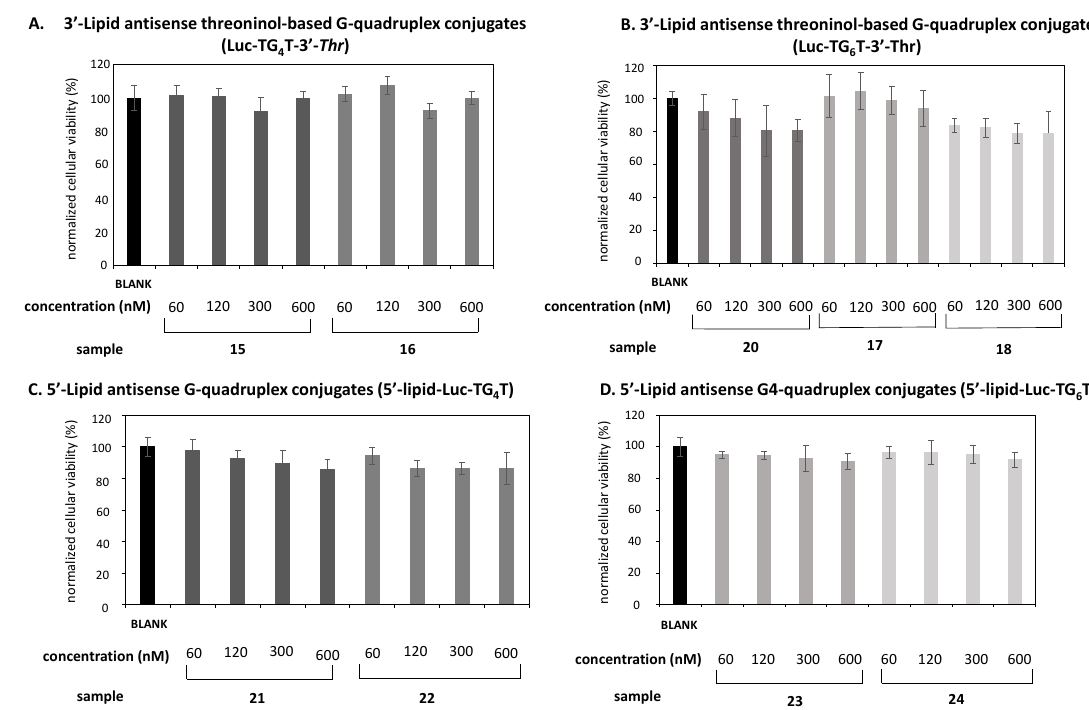
Figure 6. Cytotoxicity analysis of antisense conjugates containing four Gs ( A , C ) and six Gs ( B , D ). A lipid threoninol-based modification at the 3 ′ -termini were introduced ( A , B ); a lipid modification (C8, C14) was introduced at the 5 ′ -termini ( C , D ). Four concentrations of antisense conjugates, ranging from 60 nM to 600 nM, were used. All antisense conjugates were incubated up to 24 h at 37 °C. Data were means ±SD of three independent experiments.